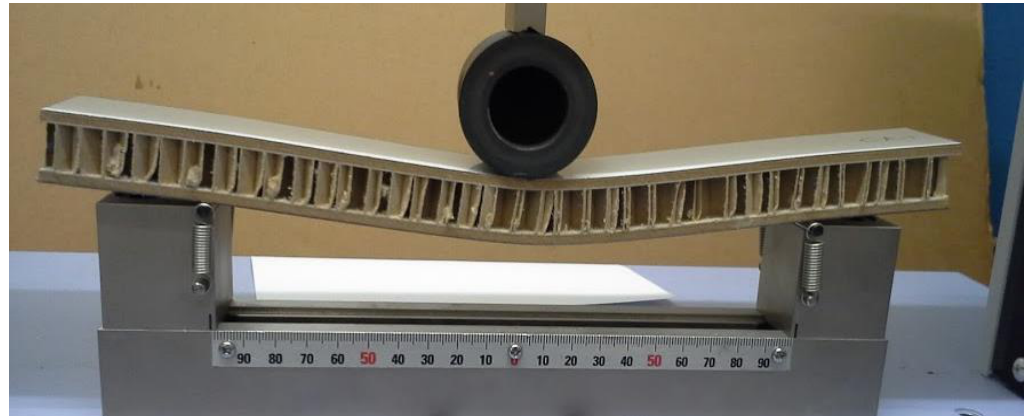
Figure 14. Bending test of sample ca1.